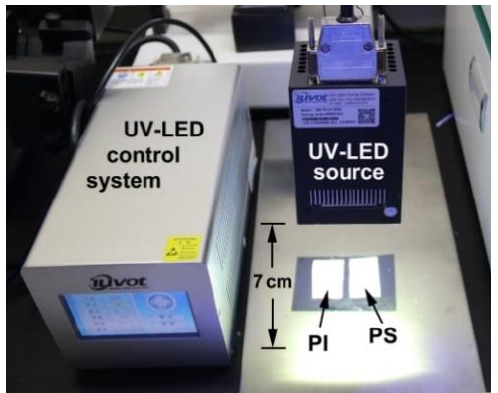
Figure 1. UV-LED exposure apparatus and measurement conditions.